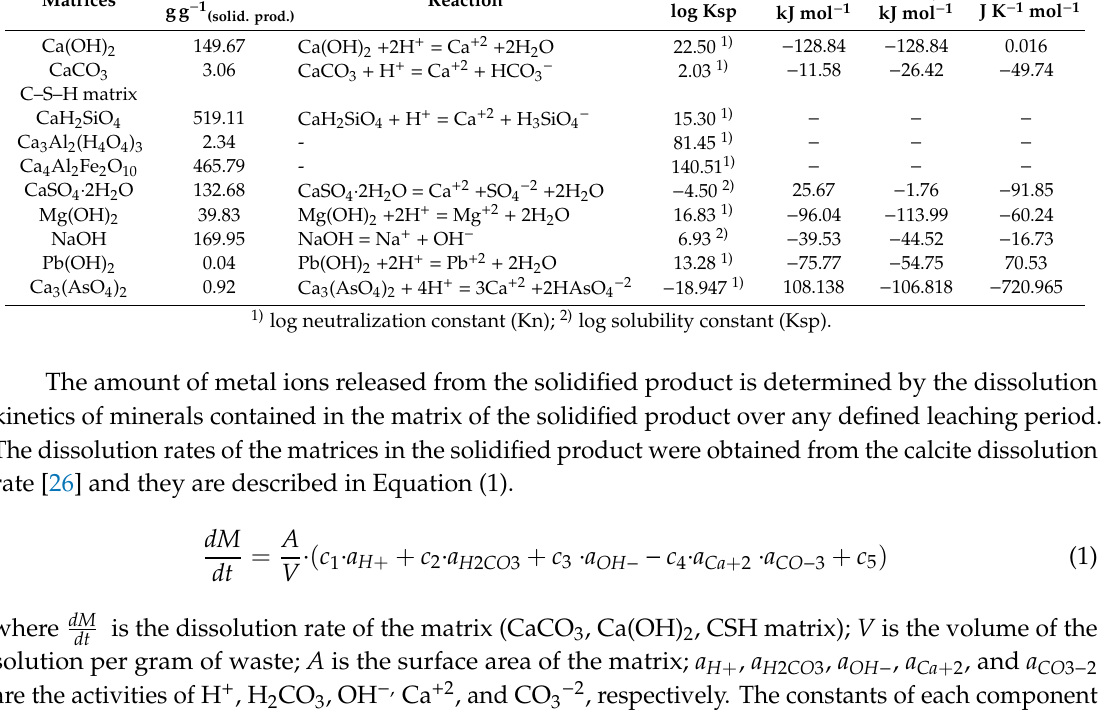
Table 3. Initial mass of minerals (25% of solidified product) and thermodynamic data of reactions [22]. In. Mass, Matrices gg − 1 (solid. prod.)